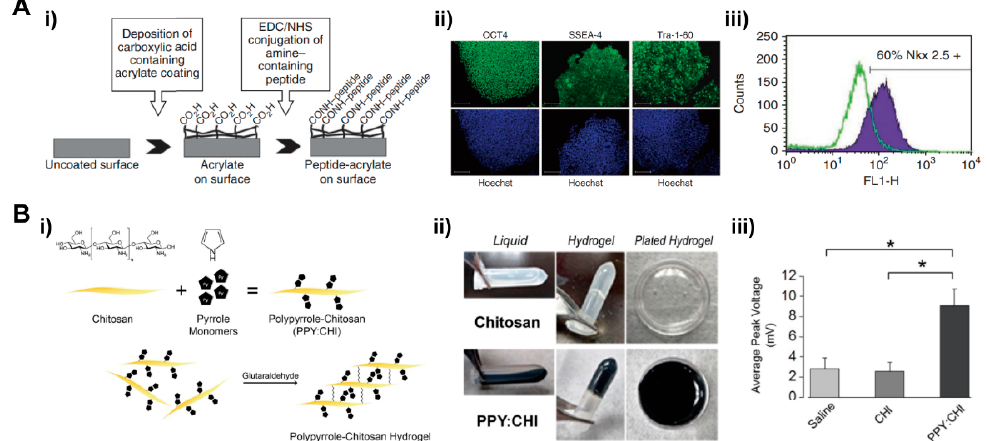
Figure 11. ( A ) Treatment process of the peptide-acrylate surfaces (PAS) on a substrate (i), pluripotent marker image of human embryonic stem cells (hESCs) on PAS surface by immunofluorescence staining, (ii) and flow cytometry analysis for Nkx2.5, which is known as cardiomyocyte marker (iii). ( B ) Generating process of polypyrrole-chitosan hydrogel (i), the degree of flexibility and rigidity of polymer hydrogels to coat culture dishes (ii), and differences in electrical signal conductivity in cryoinjured myocardial scar (* p < 0.05) (iii). Reprinted from [80,82]. Copyright (2010) Nature America,